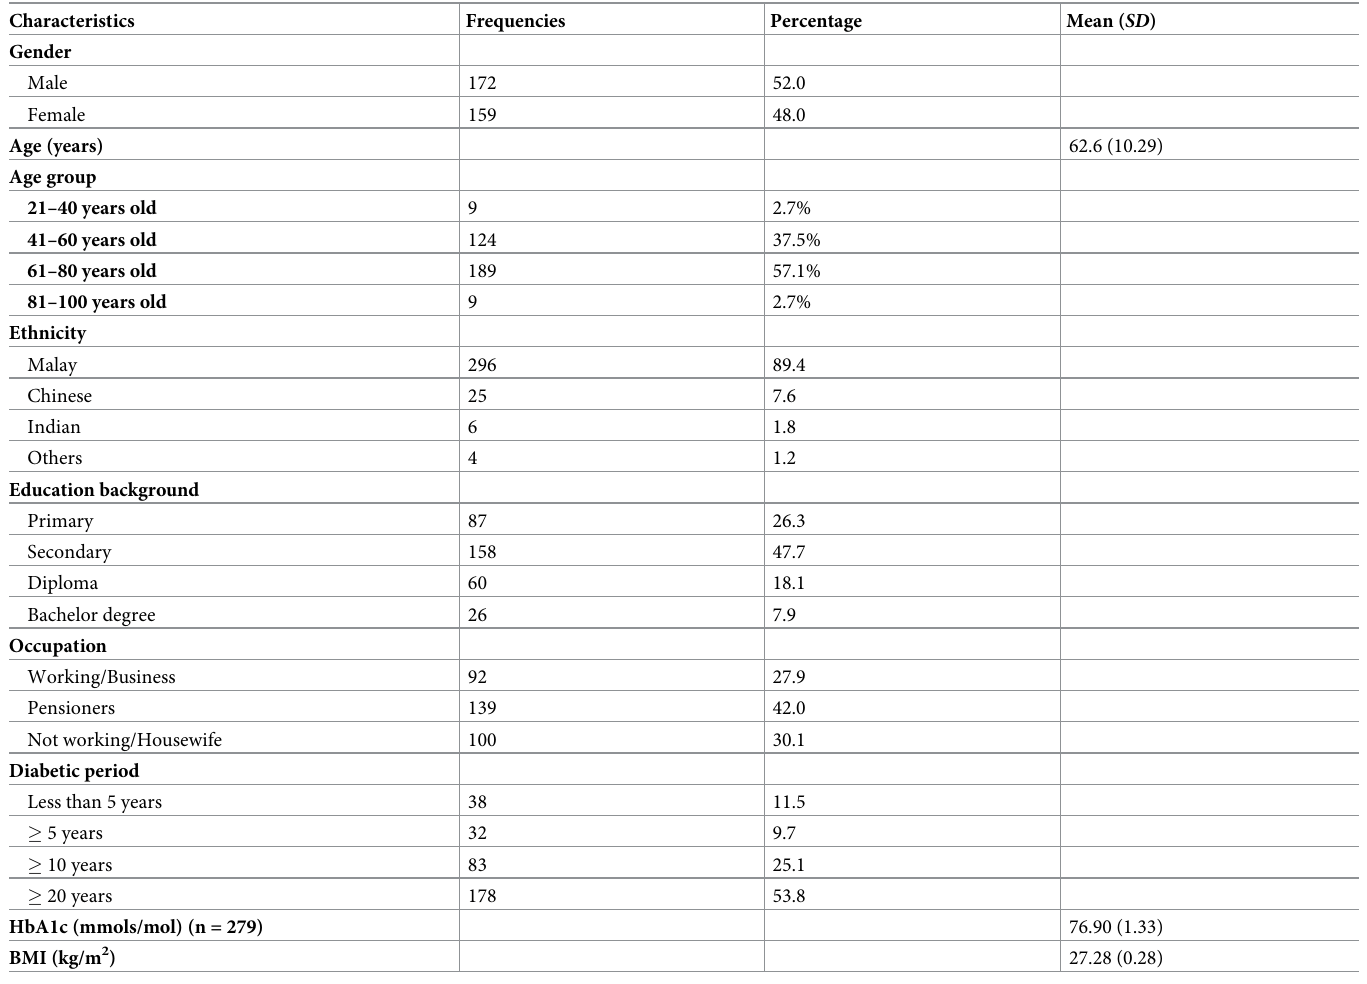
Table 1. Demographic characteristics and medical variables of people with T2DM in Hospital USM ( n = 331). Characteristics